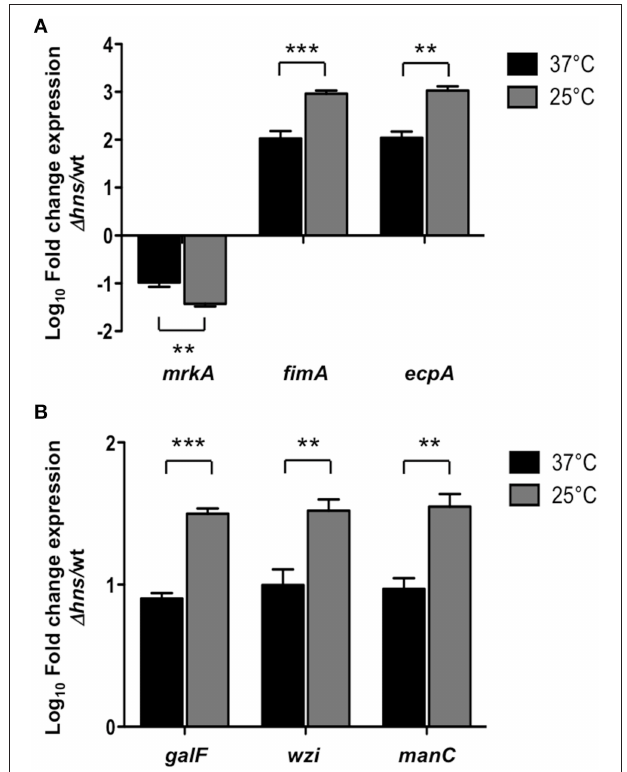
FIGURE 4 | H-NS thermoregulates both fimbrial and capsular genes. Fold-change expression (qRT-PCR) of the fimbrial (A) and capsular genes (B) in the 1 hns mutant as compared to the K . pneumoniae wild-type strain. Data represent the mean of at least three independent experiments (mean ± SD). Statistically significant with respect to the wild-type strain *** p < 0.001 ; ** p < 0.01